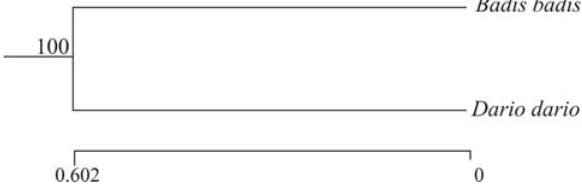
Figure 2 - UPGMA dendrogram showing genetic identity based distinct separation of Badis badis and Dario dario .